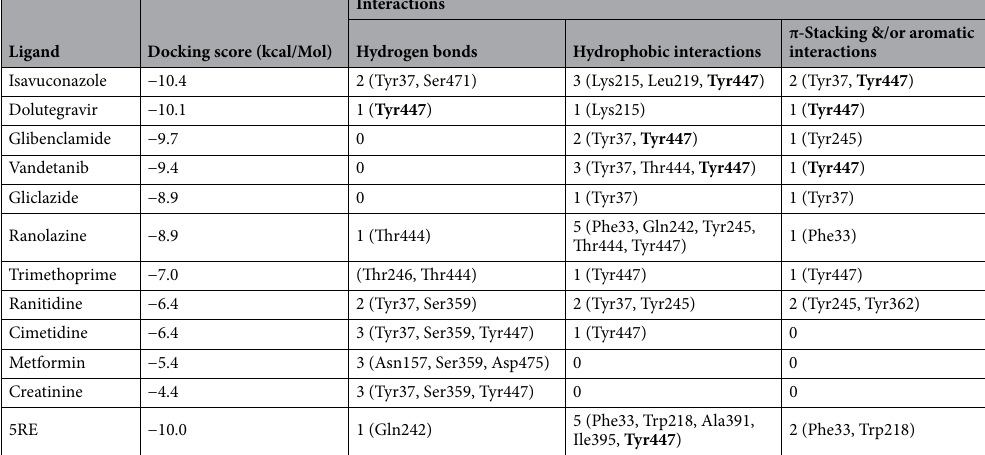
Table 9. Docking scores and number of interactions predicted for 11 drugs and 5RE inhibitor docked to the active site of SLC22A2 haplotype 4. Interactions calculated using Poseview. Number in front of brackets is the total number of interactions observed. Three letter aa code: Tyr tyrosine, Ser serine, Lys lysine, Leu leucine, Thr threonine, Phe phenylalanine, Asn asparagine, Asp aspartic acid, Ala alanine. The residues highlighted in bold shows similar interacting residues shared between the top binders: i.e. 5RE, Isavuconazole, Dolutegravir, Glibenclamide, and Vandetanib.